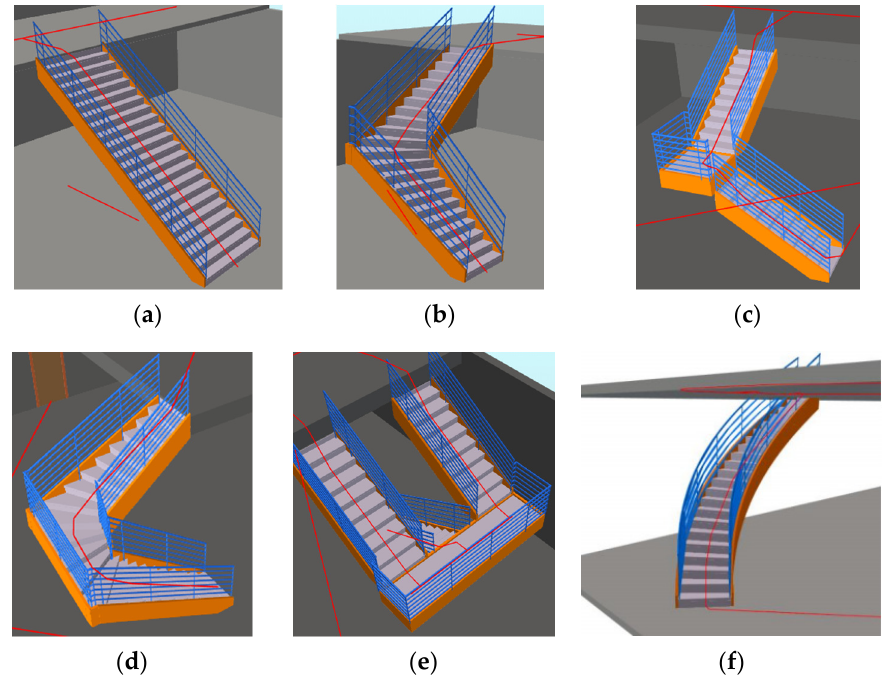
Figure 18. The generation of a 3D topological map of the evaluated stairs: ( a ) straight stair, ( b ) turn stair, ( c ) L-style stair, ( d ) n-style stair, ( e ) m-style stair, and ( f ) spiral stair.